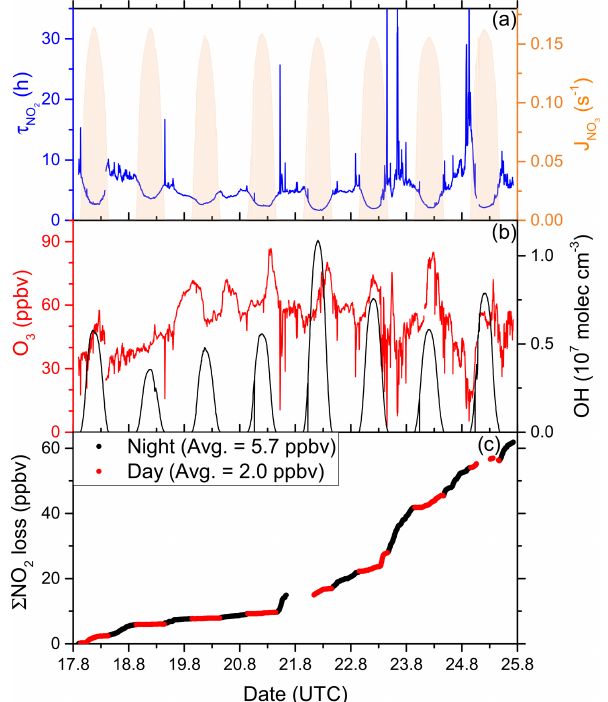
Figure 8. (a) Lifetime ( τ ) of NO 2 due to reactions with OH and O 3 along the second Red Sea leg, together with concentrations of O 3 and OH. The OH trace is an interpolation based on OH measure- ments and J (see Sect. 3.2.3). Daytime hours are indicated via O 1 D J NO . (b) Cumulative loss of NO 2 during the displayed time frame, 3 based on the calculated lifetimes and measured NO 2 .